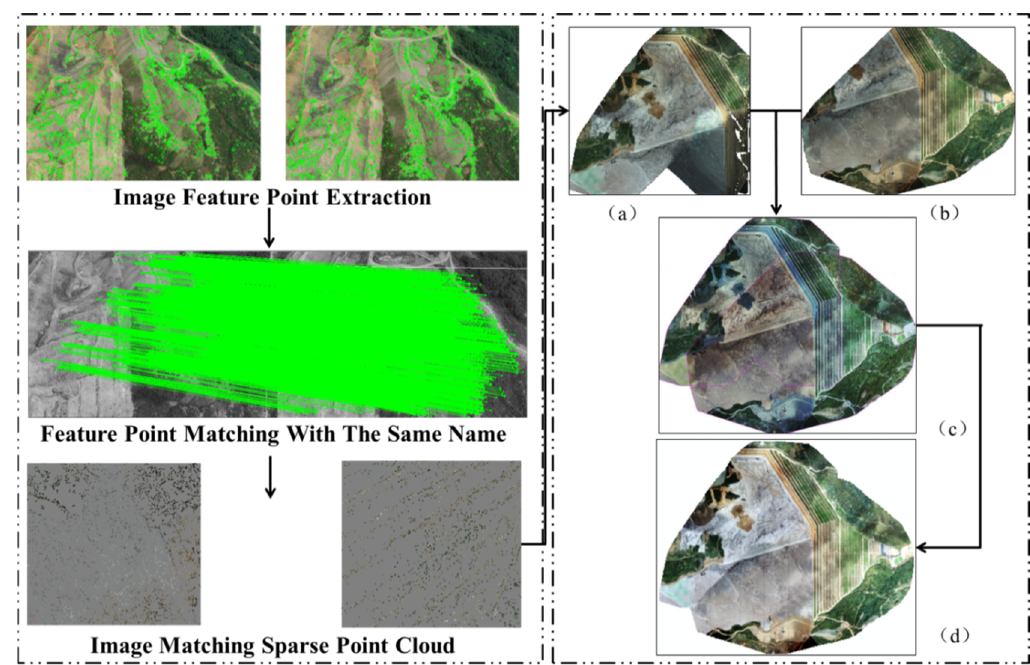
Figure 5. DOM construction process. ( a , b ) represents the result of the DOM construct. ( c ) represents the result of matching and fusion ( a , b ). ( d ) fusion chromatic difference was eliminated according to color space uniformity, and DOM was completely constructed.